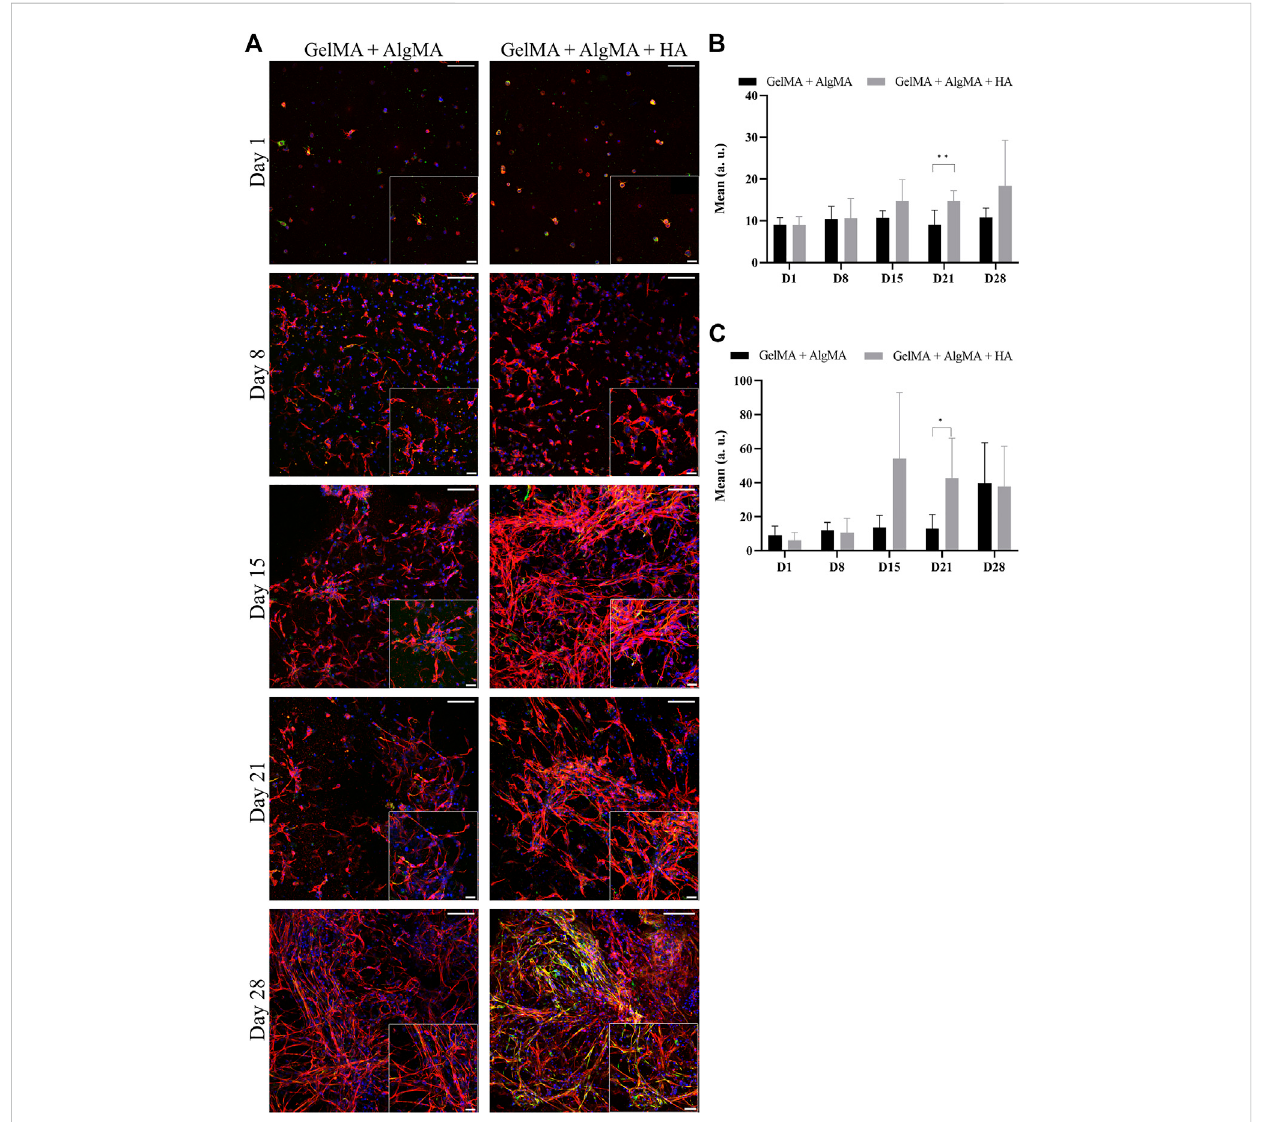
FIGURE 5 EvaluationofthedifferentiationofC17.2cellsembeddedindifferentconcentrations ofhydrogelsfor28 days. (A) Representativeconfocalimagesof immuno fl uorescenceassay.Progenitormarkernestin isstained ingreen,neuron marker β -IIItubulin isstainedinred,andnuclei arestained inblue(scale bar100 µm).Localzoomimagesareplacedinthebottomrightcornerofeachimagewithascalebarof30 µm.Quanti fi cationofthemeanexpressionof nestin (B) and β -IIItubulin (C) upto28 daysforbothhydrogelformulations.Dataarepresentedasmean±standarddeviation.Statisticalsigni fi cance was calculated using a two-way variance analysis (ANOVA) with Sídák ’ s post hoc multiple comparisons test considering * p < 0.05; ** p <